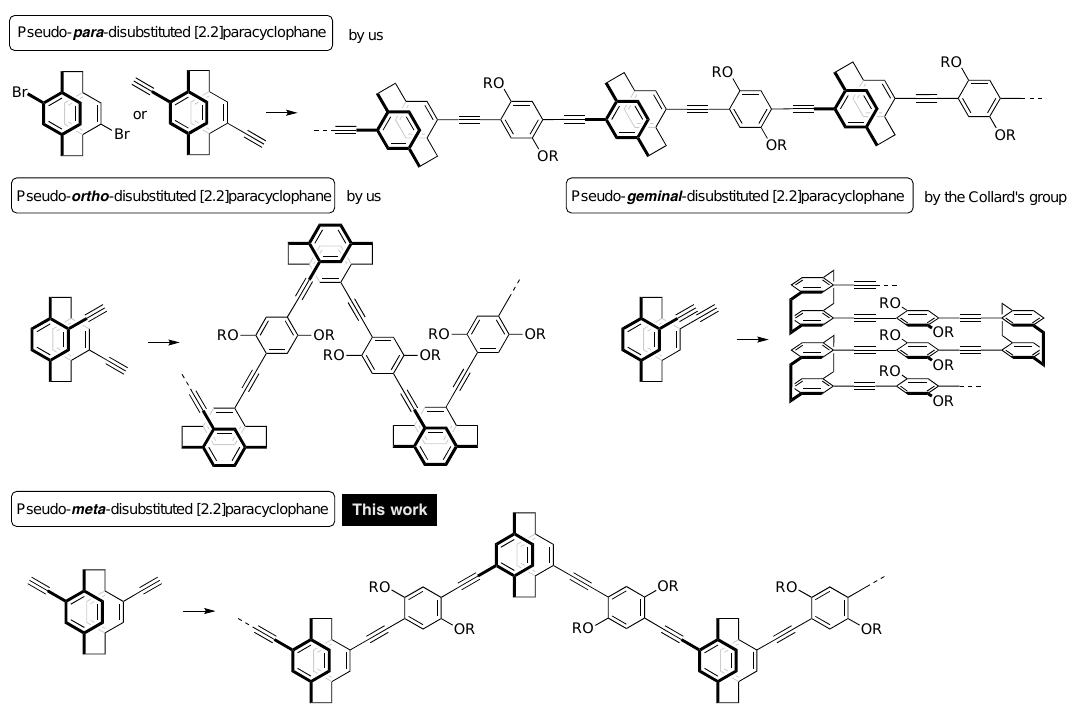
Figure 1. Poly( p -arylene-ethynylene) (PAE) type of [2.2]paracyclophane-containing through-space conjugated polymers containing various disubstituted [2.2]paracyclophane isomers.